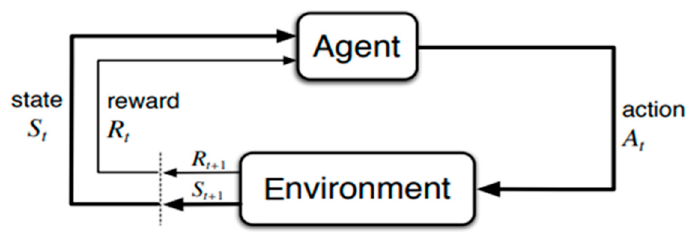
Figure 2. Agent–Environment Interaction in Markov Decision Process.